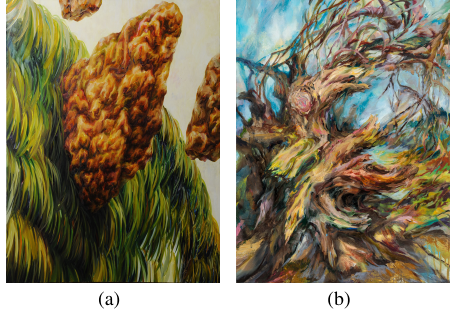
Figure 3. (a) Group A (b) Group B The different groups of paintings by Jiho